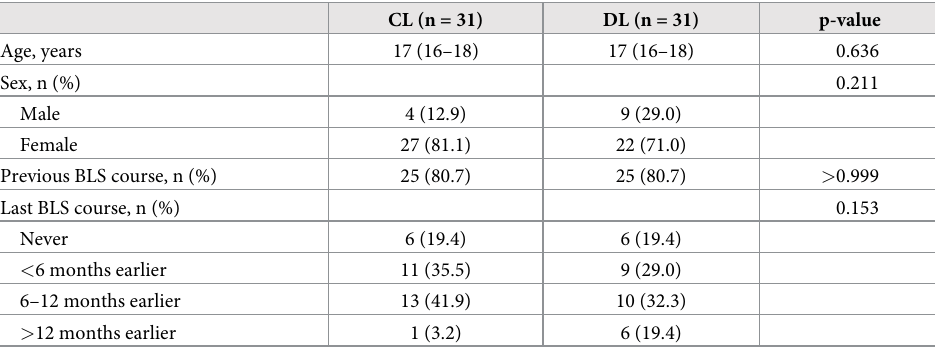
Table 1. Baseline characteristics.